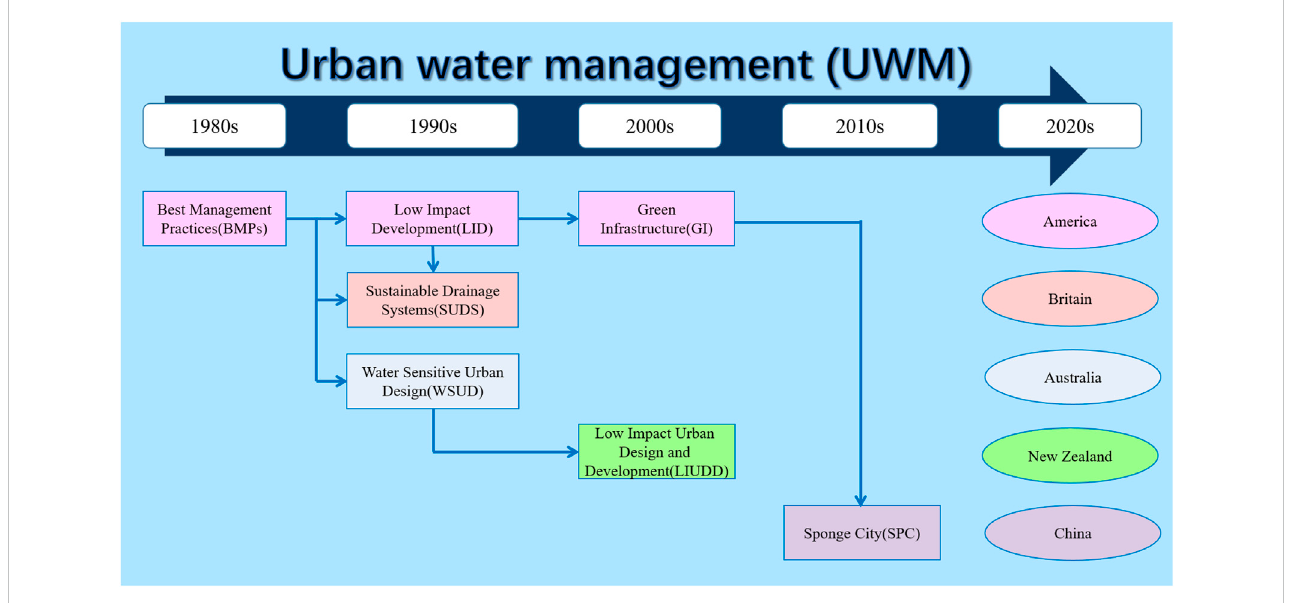
FIGURE 1 Rainwater utilization modes and developing